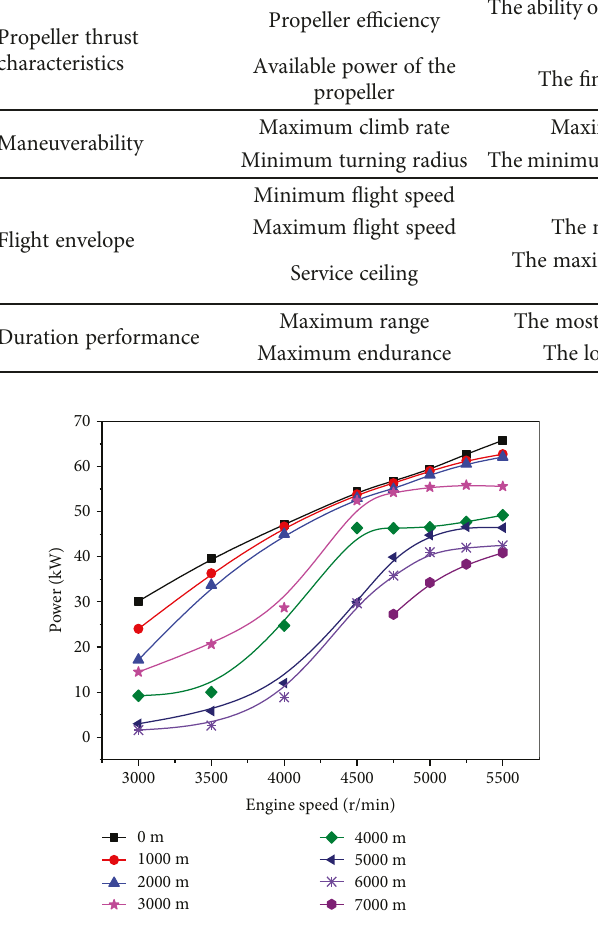
Figure 7: Output power curves at di ff erent altitudes.